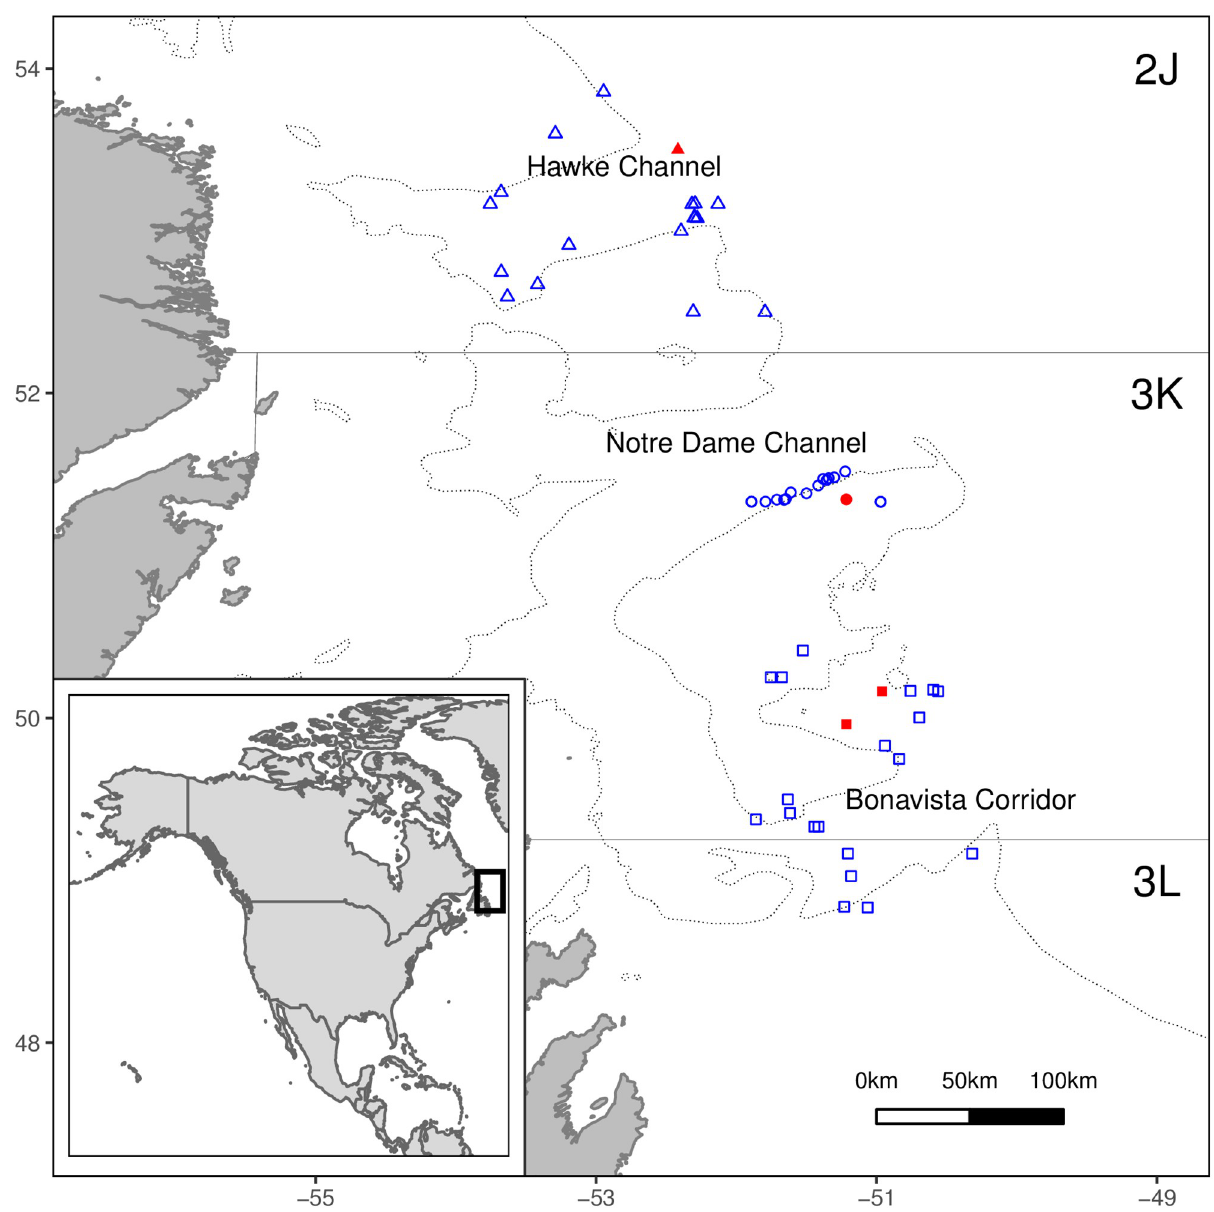
Fig 1. Map of Newfoundland and southern Labrador with sampling locations. The trawl locations are indicated with open blue symbols and plankton tow locations with closed red symbols for the Hawke Channel (HC, triangles), Notre Dame Channel (NDC, circles), and Bonavista Corridor (BC, squares). The inset map outlines the study domain in eastern Canada. The relevant NAFO subdivisions 2J, 3K, and 3L boundaries are also indicated. Dashed lines represent 300 m depth contours. The bathymetry map is reproduced from GEBCO world map 2020 (www.gebco.net) and NAFO subdivisions reproduced from NAFO